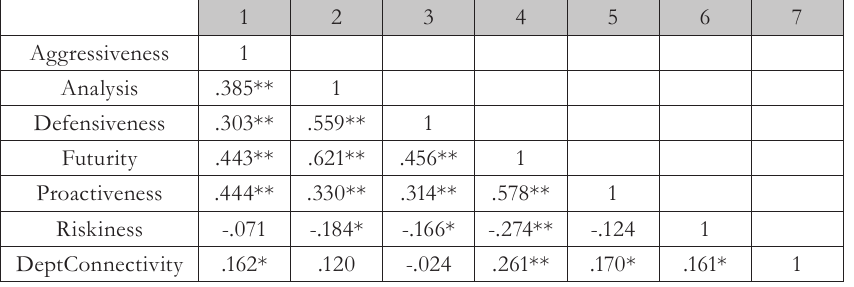
Tab. 3 - Zero-Order Correlation Co-efficient of Strategic Orientation Dimension and Depart- mental Connectivity. Source: Field